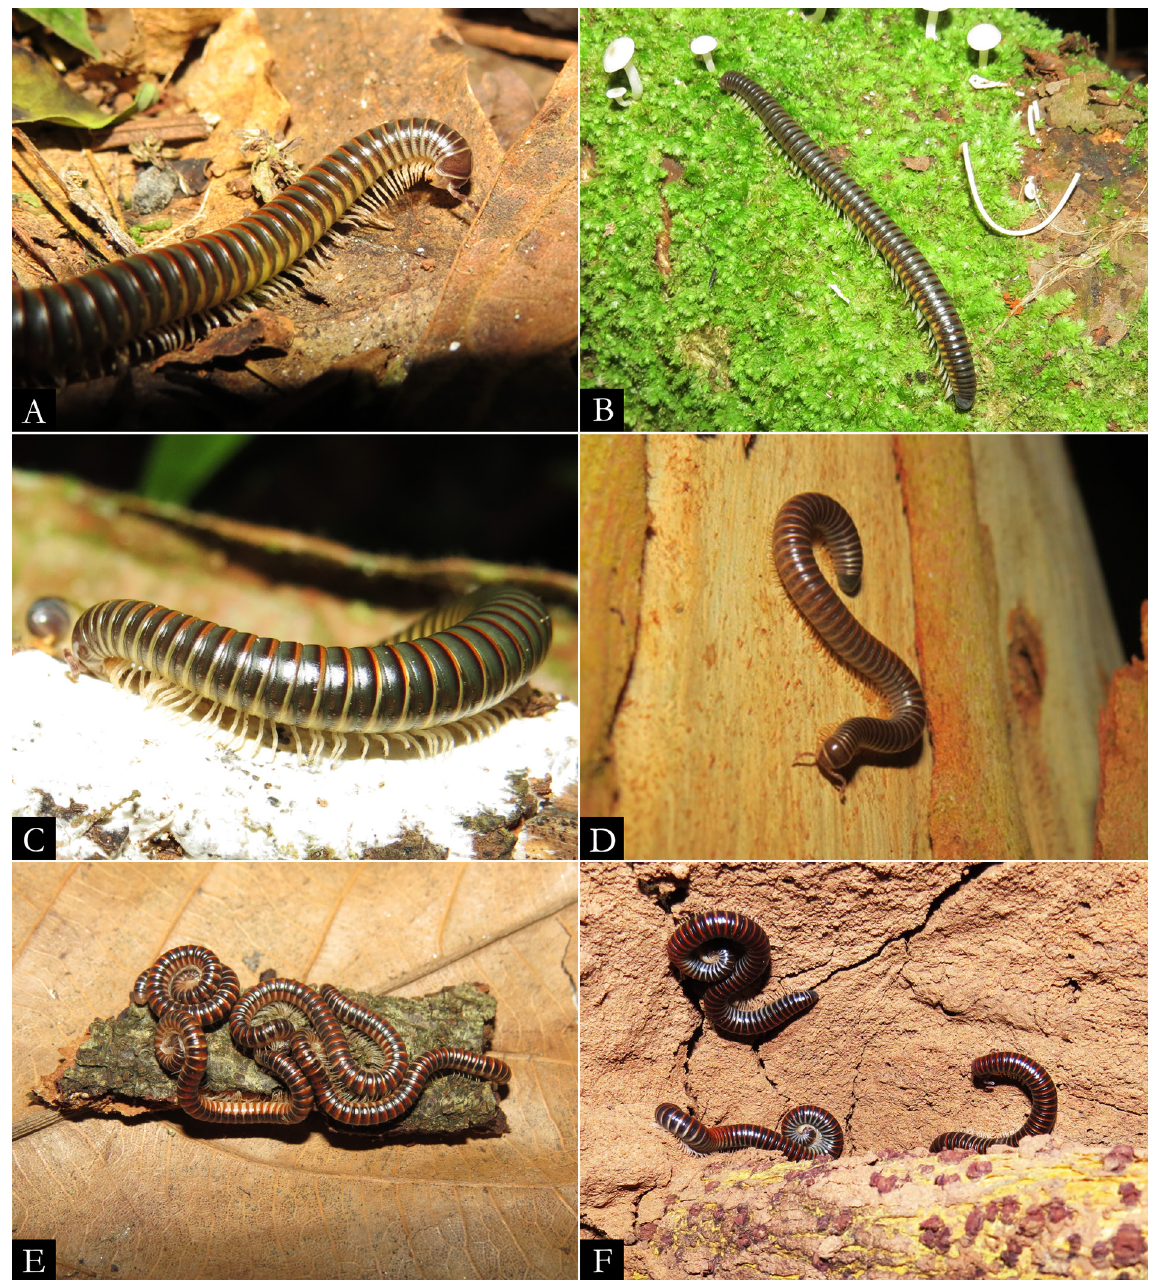
Fig. 17. Living specimens. A–C . Pseudonannolene callipyge Brölemann, 1902, from Adrianópolis, PR, Brazil. D . P. fontanettiae Iniesta & Ferreira, 2014, from Lavras, MG, Brazil. E . Pseudonannolene spp. from Piquete, SP, Brazil. F . Pseudonannolene spp. from Lassance, MG, Brazil. Photos (A–F) by L.F.M.